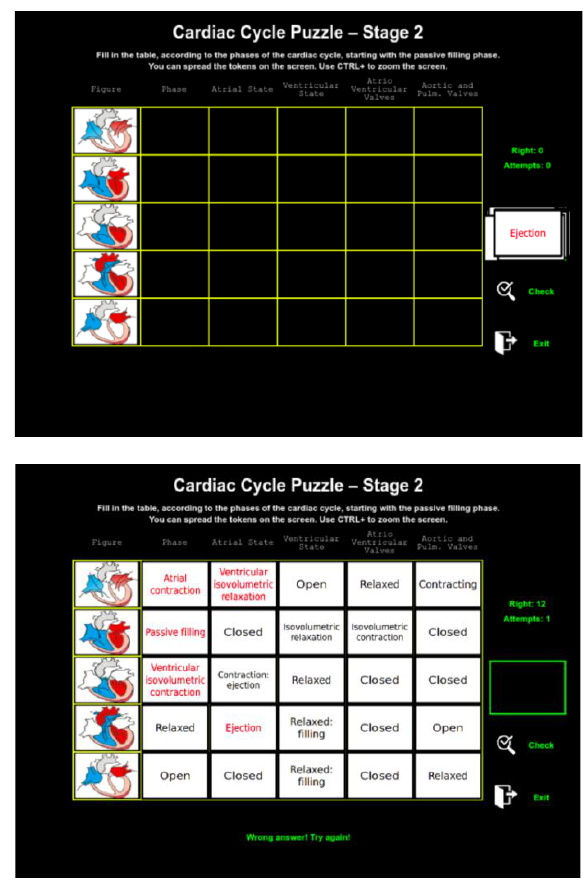
Figure 6. Stage 2 of the online digital cardiac cycle puzzle